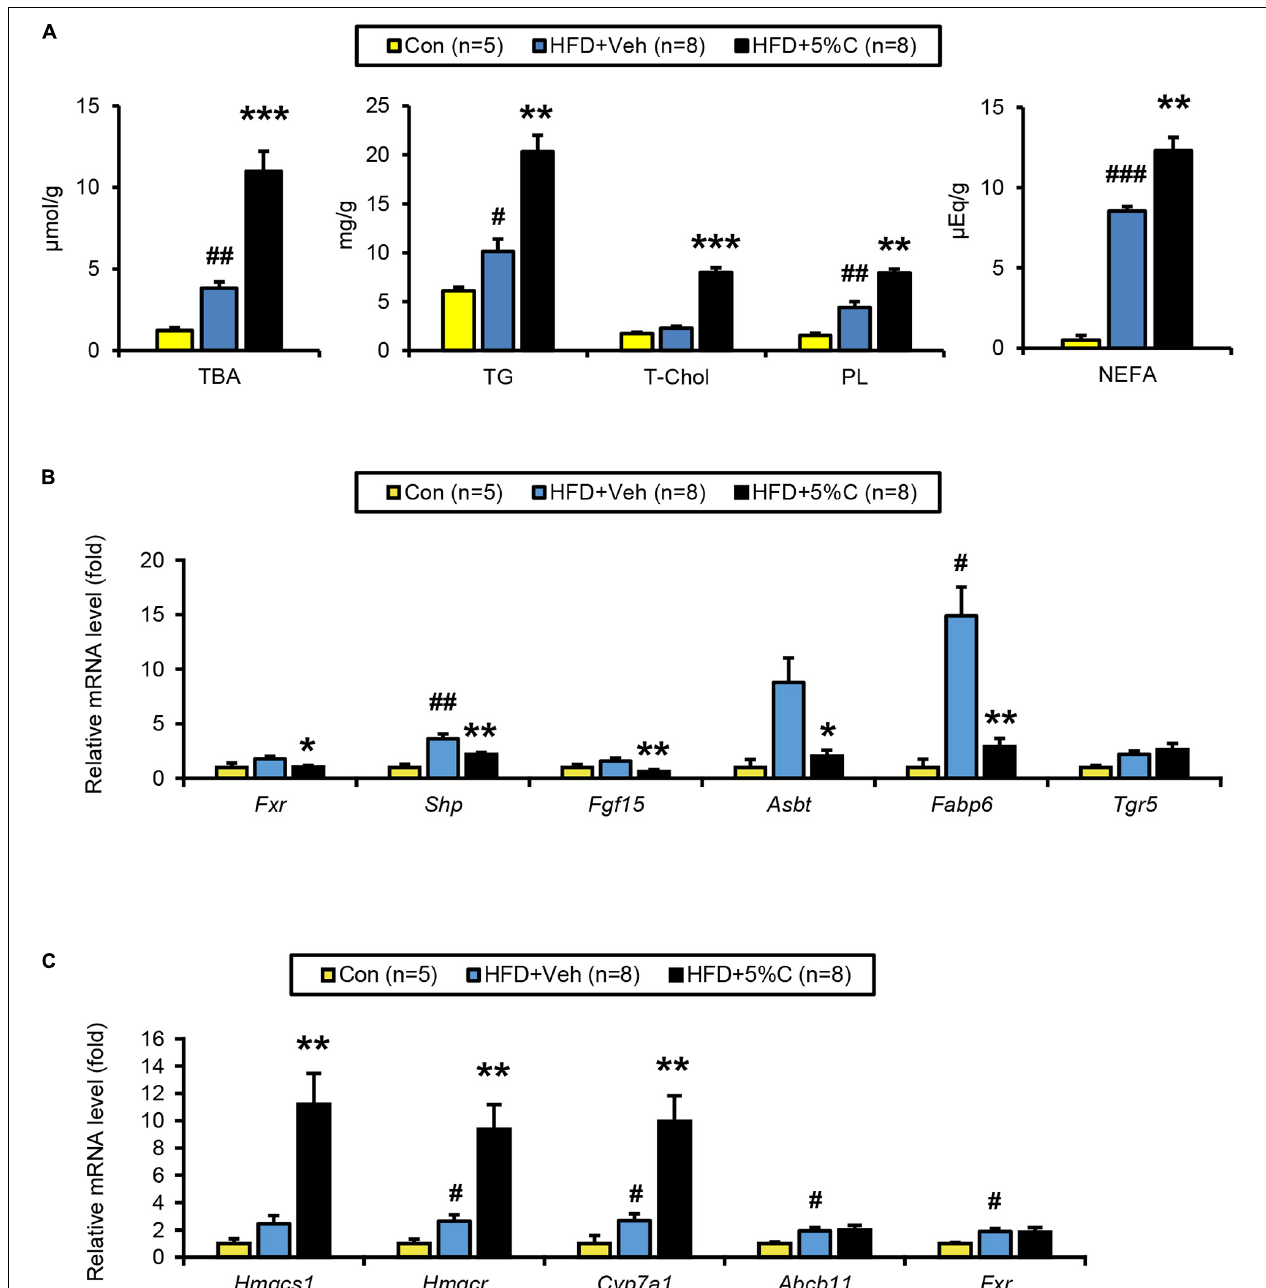
FIGURE 5 | BA metabolism is affected by activated charcoal treatment. (A) Quantitative analysis of TBA, TG, T-Chol, PL, and NEFA in cecal contents. (B) The mRNA levels of genes related to BA metabolism ( Fxr, Shp, Fgf15, Asbt , Fabp6 , and Tgr5 ) in the intestine. (C) The mRNA levels of genes related to BA/cholesterol metabolism ( Hmgcs1, Hmgcr , Cyp7a1, Abcb11 , and Fxr ) in the liver. Data are expressed as the mean ± SEM. Statistical analysis was performed using two-tailed Student’s t -tests. * P < 0.05, ** P < 0.01, and *** P < 0.001 between the HFD + Veh group and the HFD + 5%C group. # P < 0.05, ## P < 0.01, and ### P < 0.001 between the HFD + Veh group and the Con